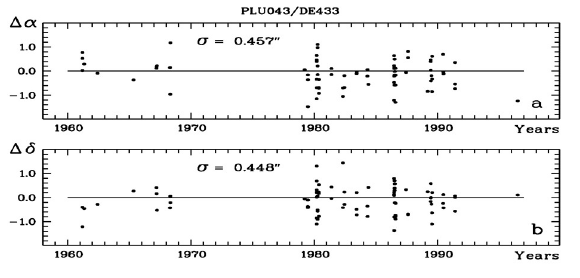
Figure 14. The distribution of O-C Pluto on both